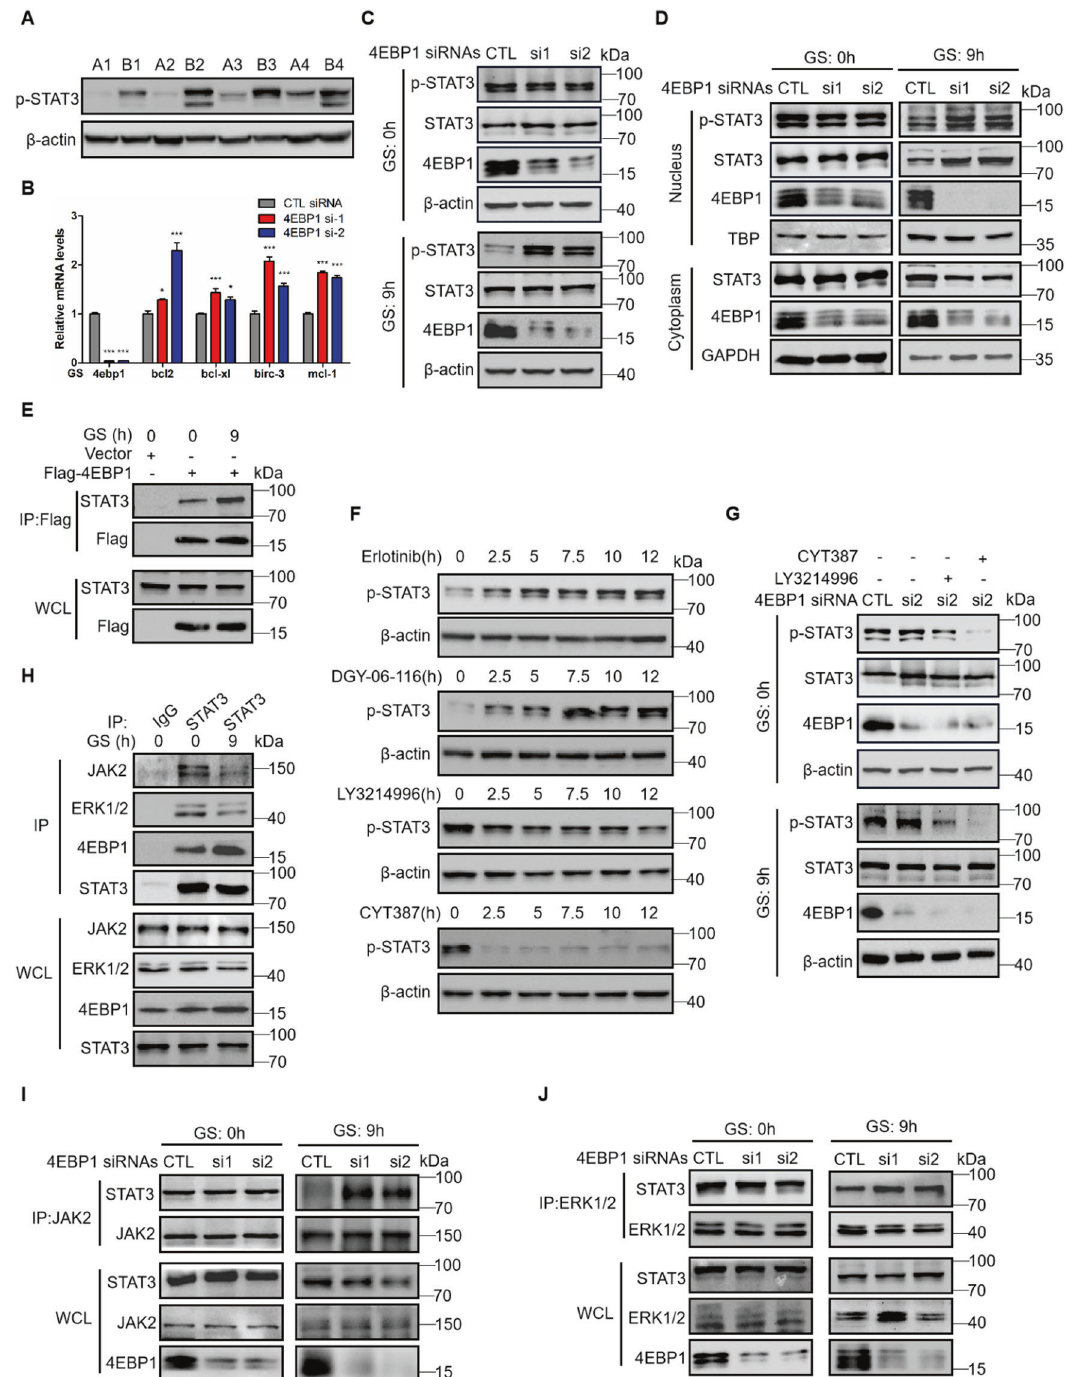
Fig. 5 4EBP1 induces apoptosis via inactivation of STAT3 under glucose deprivation conditions. A The protein levels of p-STAT3 (Y705) were checked by western blot using the paired, tumor-central region ( A ) and tumor-peripheral region ( B ) derived from four lung adenocarcinoma patients. B – D A549 cells transfected with either control (CTL) siRNA or 4EBP1 siRNAs were treated with normal (0 h) or glucose starvation for 9 h. B q-PCR analysis of STAT3 downstream target genes expression. The data represent the averages of three independent experiments (mean ± SD). * P < 0.05, *** P < 0.001. C Western blot analysis of p-STAT3 (Y705) expression. D Western blot analysis of STAT3 and p-STAT3 (Y705) expression in the nuclear and cytoplasmic fractions. E A549 cells transfected with plasmid Flag-4EBP1 or vector were treated with normal or glucose starvation for 9 h. The immunoprecipitation was done using anti-Flag antibody followed by western blot. WCL: the whole cell lysate. F A549 cells were treated with Erlotinib, DGY-06-116, LY3214996 or CYT387. Western blot analysis of p-STAT3 (Y705) expression. G A549 cells transfected with either control siRNA or 4EBP1 siRNAs were treated with CYT387 or LY3214996 for 10 h in normal or glucose starvation conditions. Western blot analysis of p-STAT3 (Y705) expression. H A549 cells were treated with normal or glucose starvation for 9 h. The immunoprecipitation was done using anti-STAT3 antibody followed by western blot. I , J A549 cells transfected with either control siRNA or 4EBP1 siRNAs were treated with normal or glucose starvation. The immunoprecipitates using anti-JAK2 ( I ) or anti-ERK1/2 ( J ) antibody were blotted with related